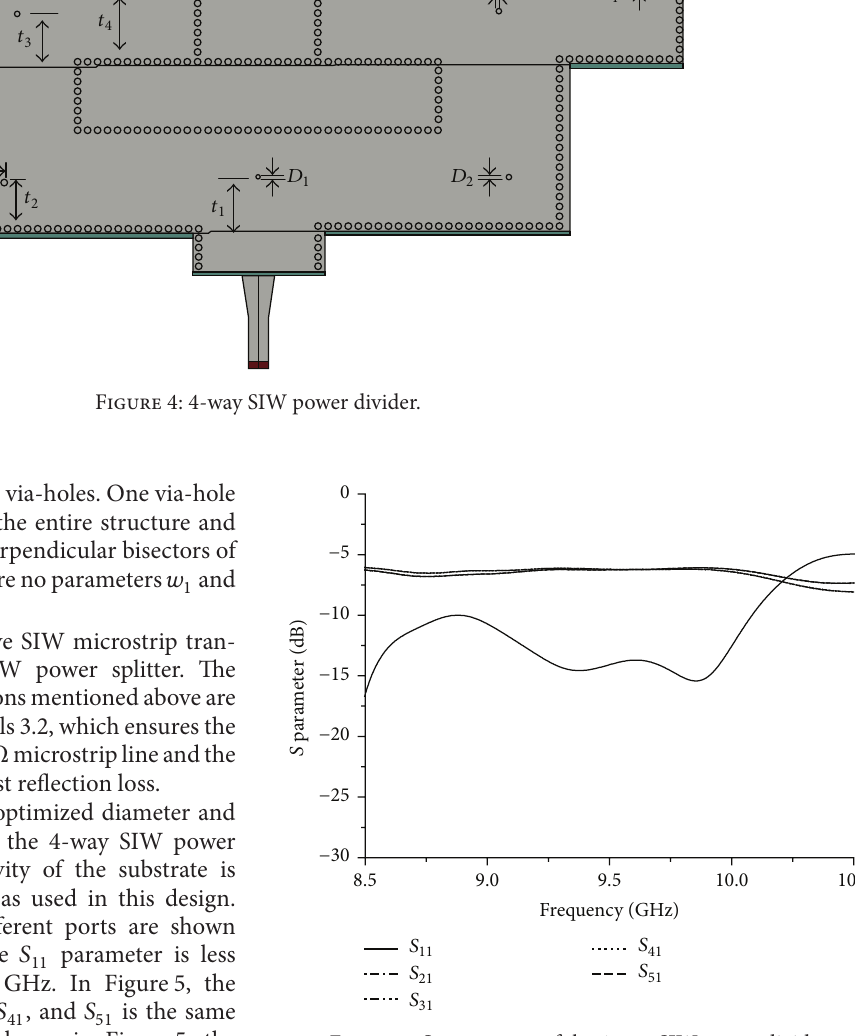
Figure 5: 𝑆 parameters of the 4-way SIW power